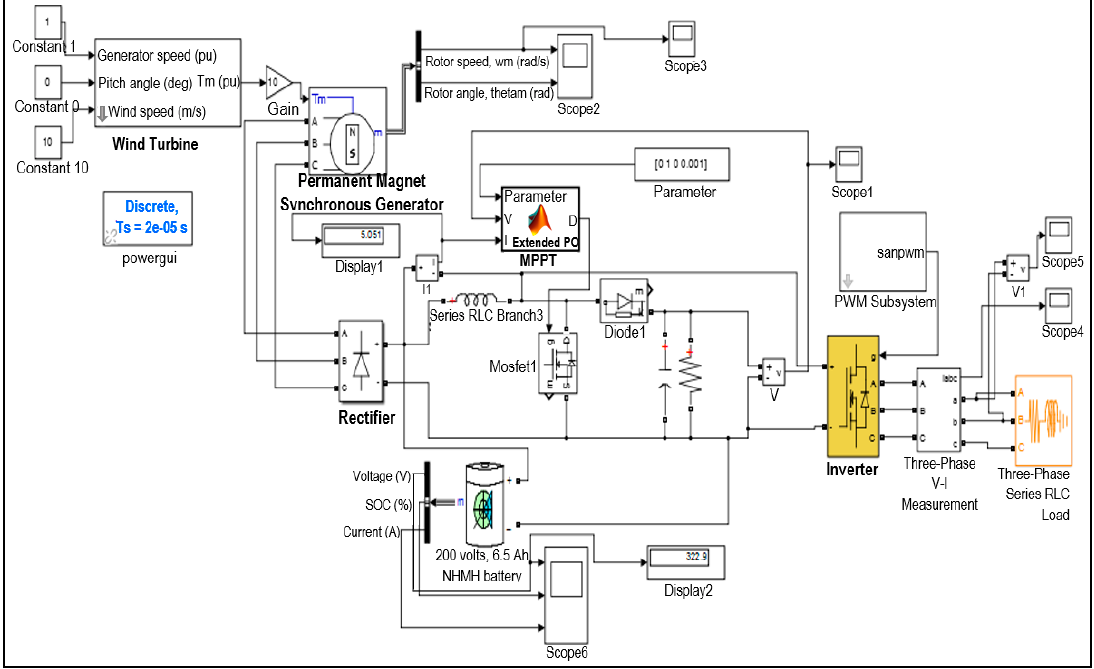
Figure 7. Wind turbine circuit diagram system with MPPT in the Simulink-Matlab software.